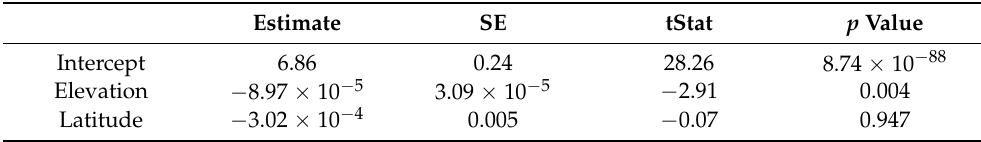
Table 1. Bivariate regression statistics table with elevation and latitude as variables (y = x 1 + x 2 × elev + x 3 × lat). Estimate SE tStat p Value Intercept 6.86 0.24 28.26 8.74 × 10 − 88 Elevation − 8.97 × 10 − 5 Latitude − 3.02 × 10 − 4 0.947